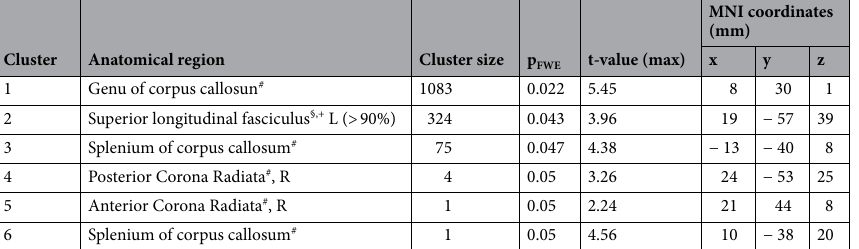
Cluster Anatomical region Cluster size p FWE t-value